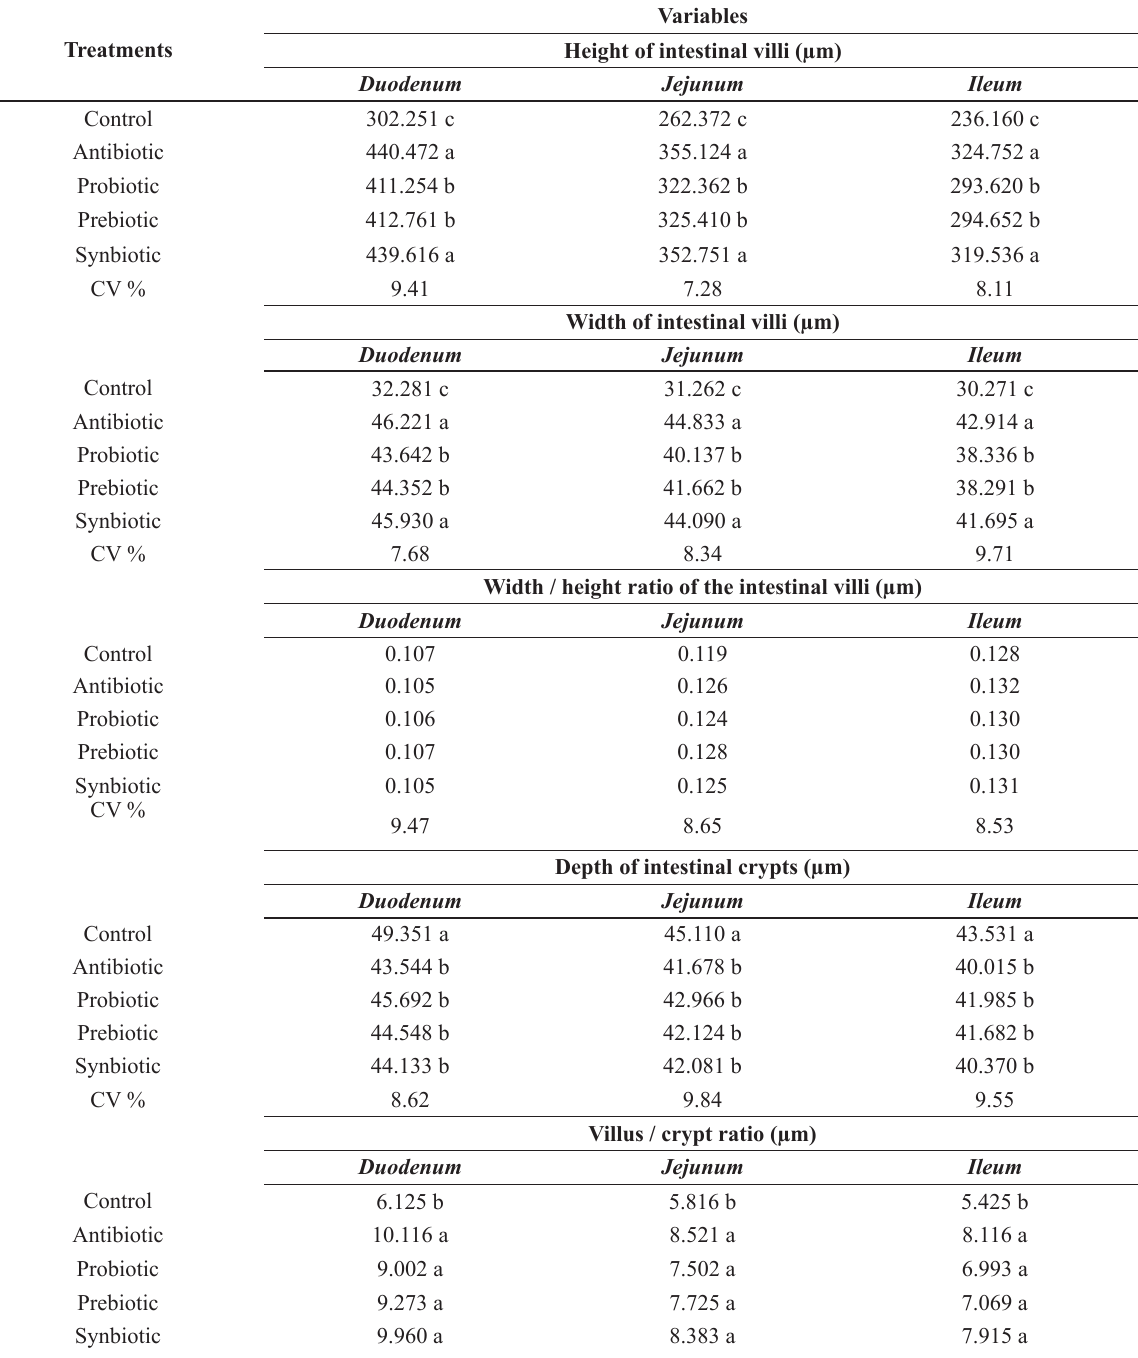
Morphology of the intestinal segments of Japanese quails fed diets containing different additives during the productive period (9-39 weeks of